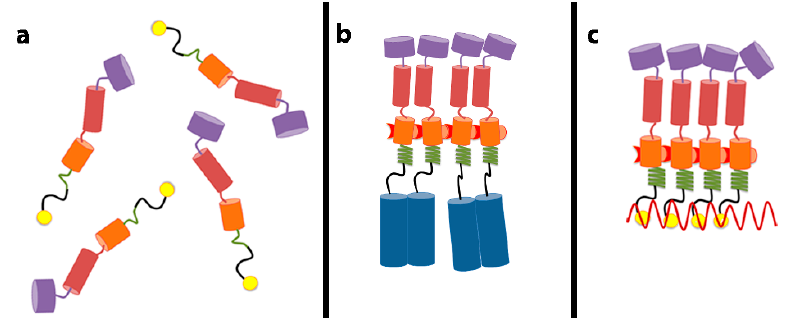
Figure 1. Schematic depiction of changes in Gag leading to assembly. ( a ) Gag contains several domains: matrix (MA, purple), the N ‐ terminal domain of capsid (CA, red), the C ‐ terminal domain of CA (orange), spacer 1 (SP1) (green), nucleocapsid (NC, yellow), and spacer 2 (SP2) and p6 (not shown). SP1 is unstructured in free Gag; ( b ) When NC is replaced by a dimerizing leucine zipper (blue cylinders), the dimerization mediated by the zipper induces SP1 to fold into a helical conformation. We propose that this leads to the appearance of new interfaces within CA for Gag–Gag interaction; ( c ) Gag molecules can also be brought into close proximity by binding cooperatively to an RNA molecule (wavy red line). This also causes helix formation in SP1 and interface formation in CA. We propose that this is a step in normal virion assembly.